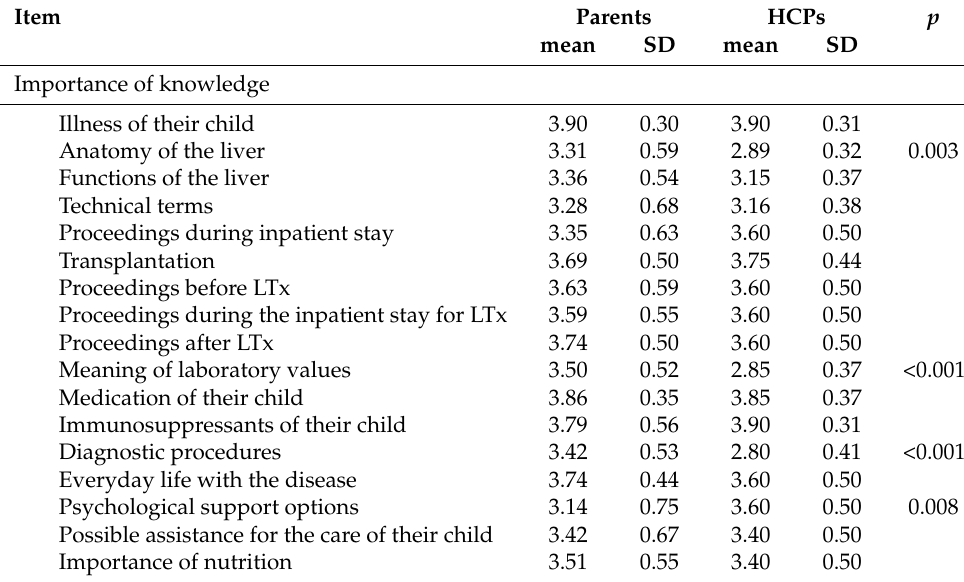
Table 4. Importance of knowledge as assessed by parents and